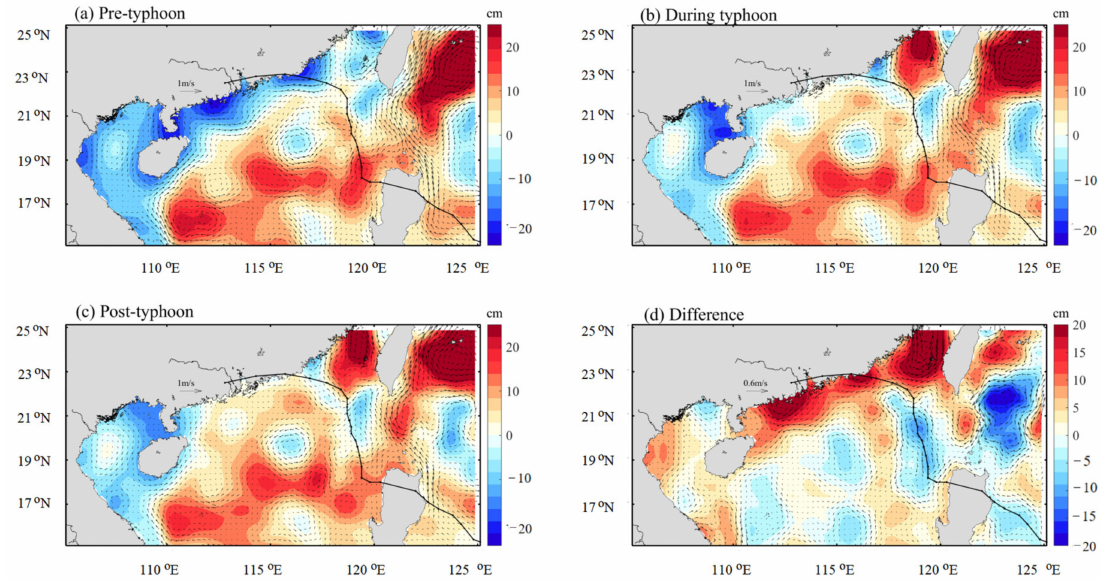
Figure 5. Spatial distribution of sea level anomaly (shading) and geostrophic current (arrow) during pre-typhoon ( a ) 1–5 July, during typhoon ( b ) 6–9 July, and post-typhoon ( c ) 10–12 July, and difference ( d ) 10–12 July minus 1–5 July. The black line denotes typhoon